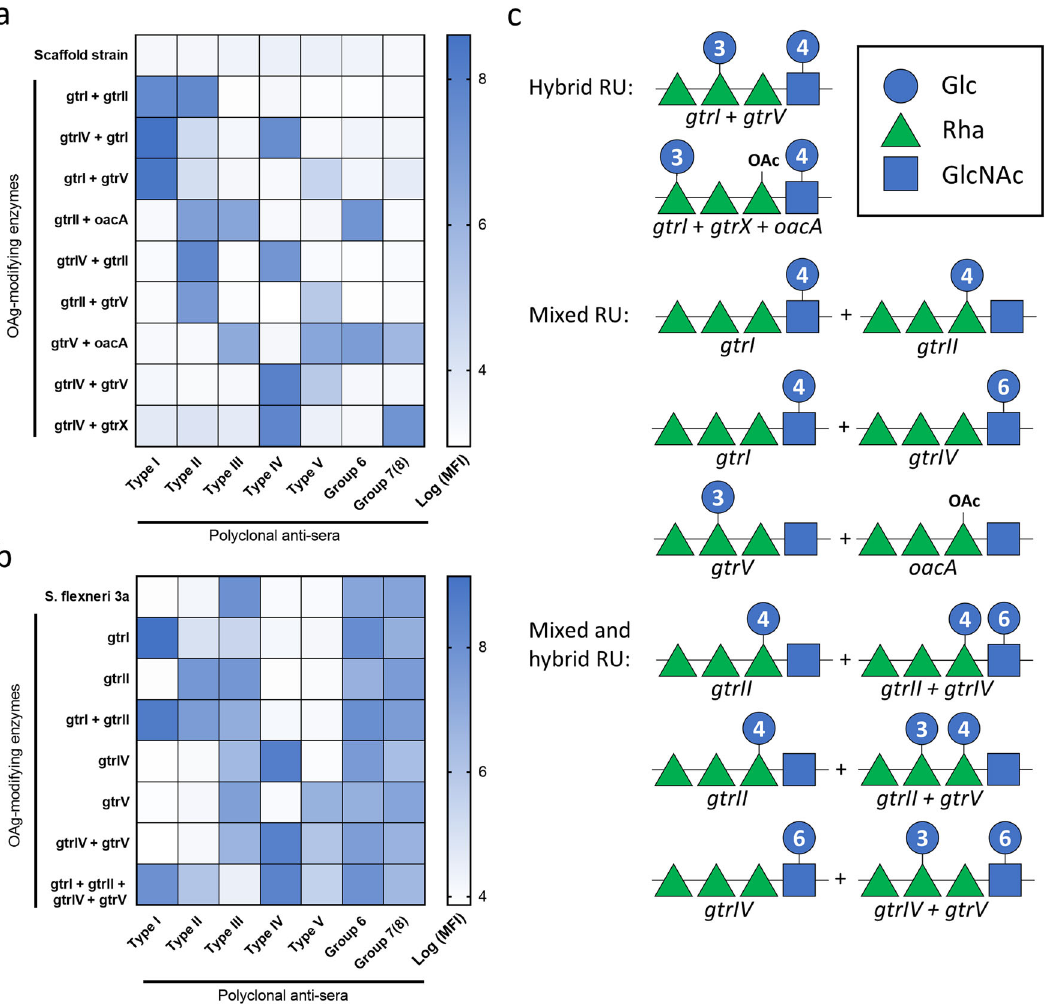
Fig. 3 Engineering of naturally non-occurring combinations of OAg-modifying enzymes. a FACS typing analysis of all strains generated by transforming the serotype Y scaffold strain. b FACS typing analysis of all strains generated by transforming S. fl exneri 3a. c Resulting OAg structures as veri fi ed by 1